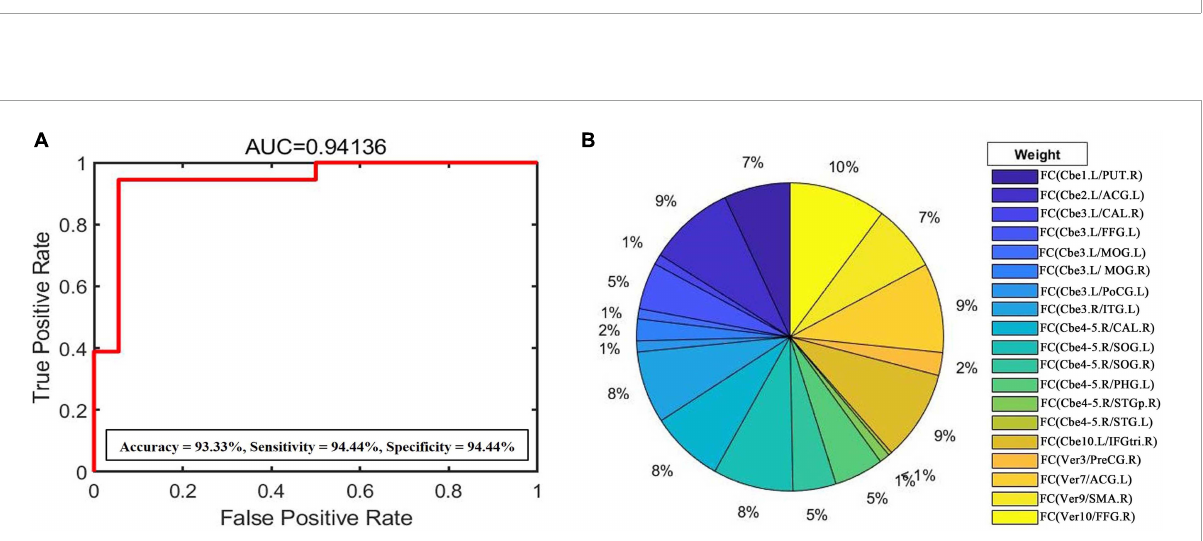
FIGURE3 (A) Support vector machine (SVM) weight analysis was performed according to the predicted results to evaluate the impact of FC changes of each cerebellar subregion following CTSCI. The AUC value, accuracy, sensitivity, and specificity of this binary classification were 0.94, 93.33, 94.44, and 94.44%, respectively. (B) SVM weight analysis showed that the FC values between the vermis_10 and right fusiform gyrus had the greatest weight in the functional changes of CTSCI. FC, functional connectivity; CTSCI, complete thoracolumbar spinal cord injury; AUC, area under the curve; Cbe, cerebellum; Ver, vermis; PUT, Putamen; ACG, anterior cingulate gyrus; CAL, calcarine; FFG, fusiform; MOG, middle occipital gyrus; PoCG, postcentral gyrus; ITG, inferior temporal gyrus; SOG, supra-occipital gyrus; PHG, parahippocampal gyrus; STGp, superior temporal pole; STG, superior temporal gyrus; IFGtri, trigonometric inferior frontal gyrus; PreCG, precentral gyrus; SMA, supplementary motor area; R, right; L,